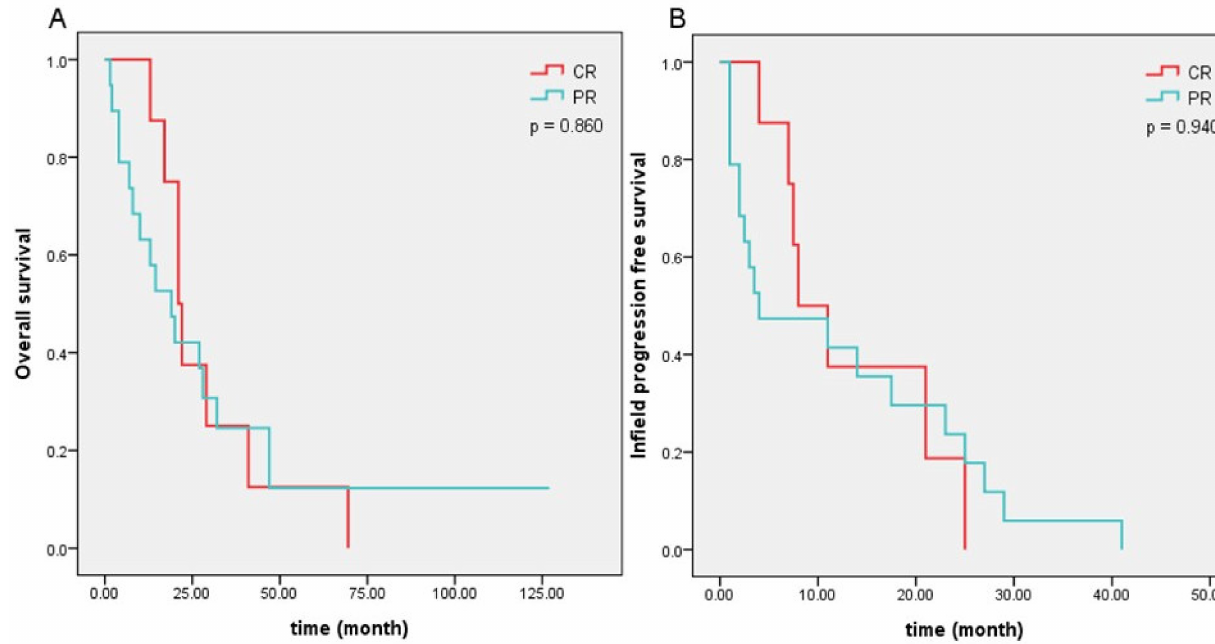
Figure 2. ( A ) Overall survival for the patients with complete remission (CR) and the patients with partial remission (PR); ( B ) infield progression-free survival for the patients with CR and the patients with